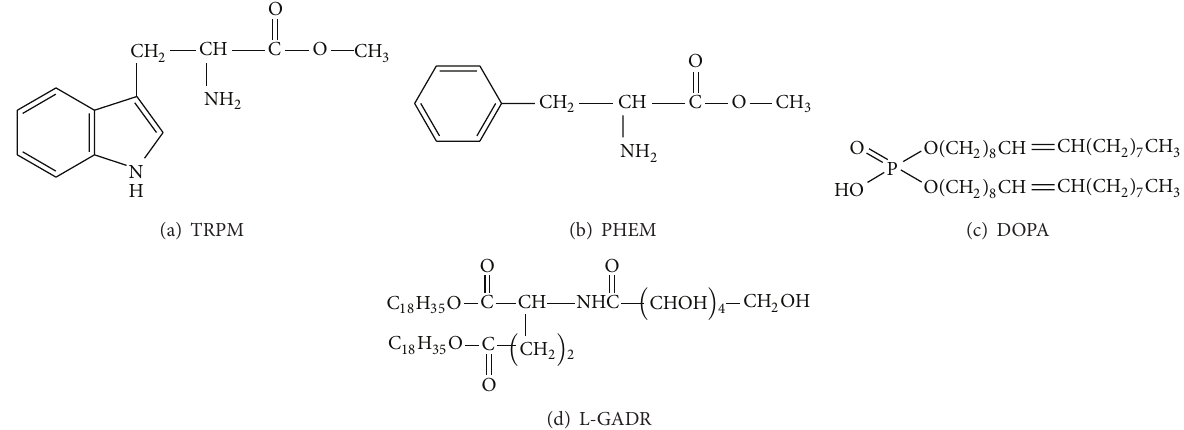
Figure 1: Molecular structures of (a) TRPM, (b) PHEM, (c) DOPA, and (d)